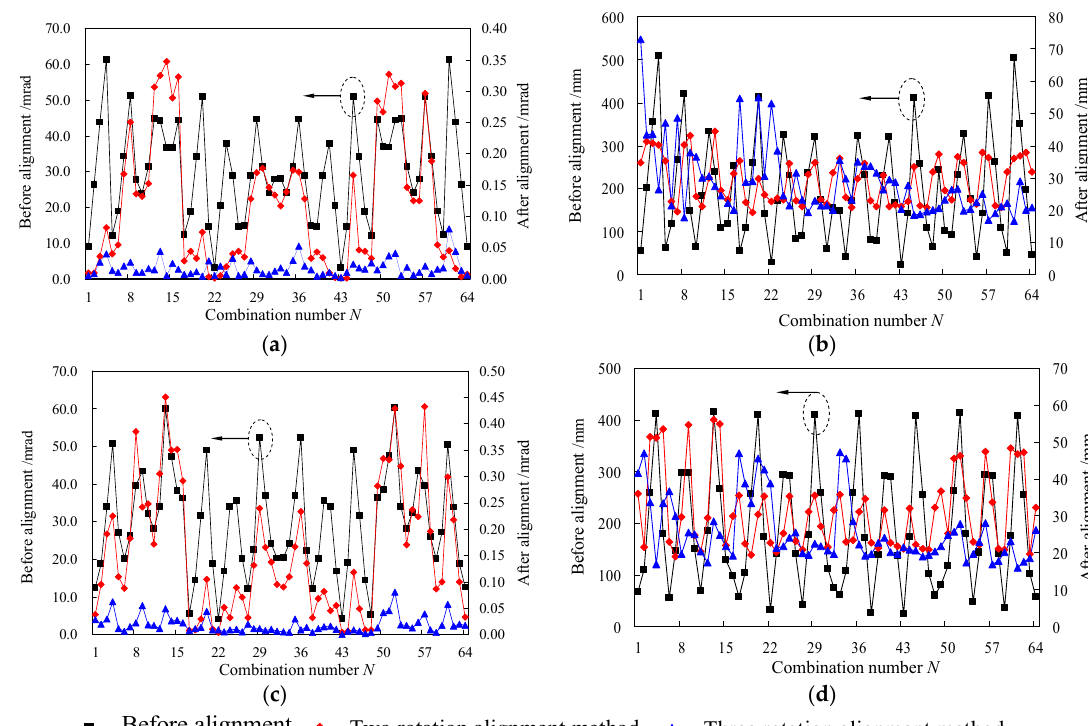
Figure 8. The numerical results of the facet alignment of the mirror unit using two ‐ rotation and three ‐ rotation alignment methods (from Parts 1 and 2): ( a ) error angle θ of the axis vector in Part 1, ( b ) error distance L of the vertex in Part 1, ( c ) error angle θ of the axis vector in Part 2, and ( d ) error distance L of the vertex in Part 2.